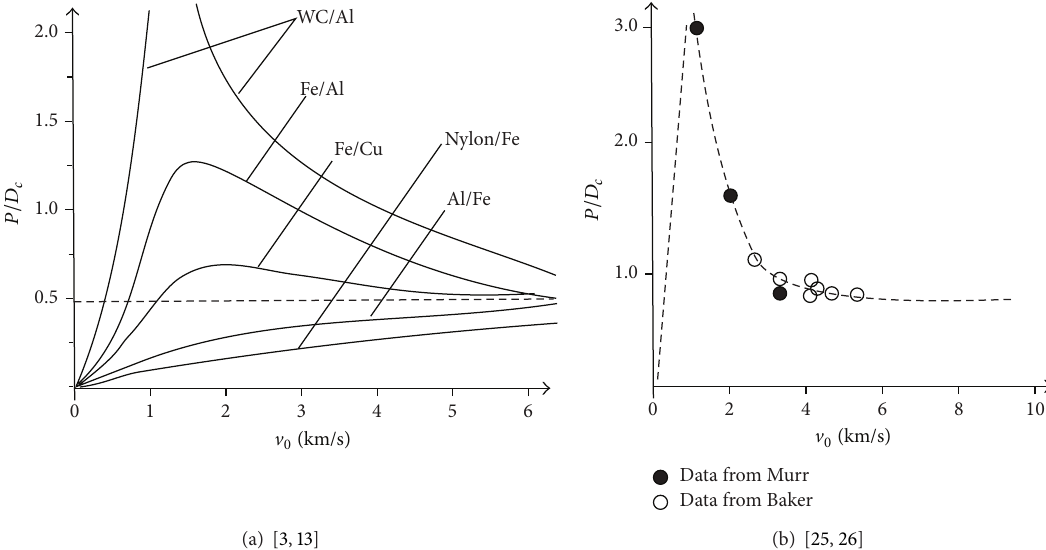
Figure 2: The crater surface pressure versus time.